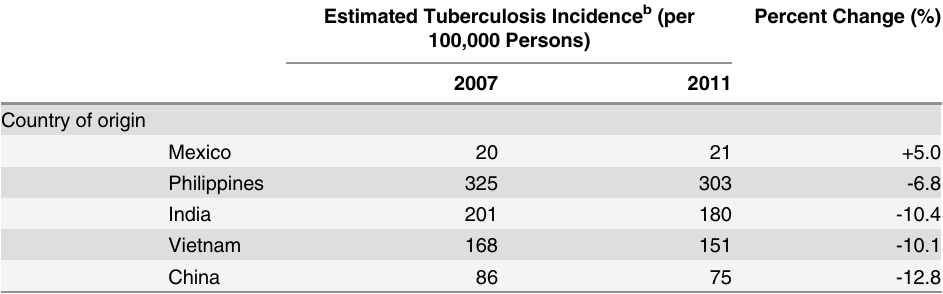
Table 4. Changes in Estimated Overseas Tuberculosis Incidence for the Top Five Countries of Ori- gin a , 2007 and 2011.